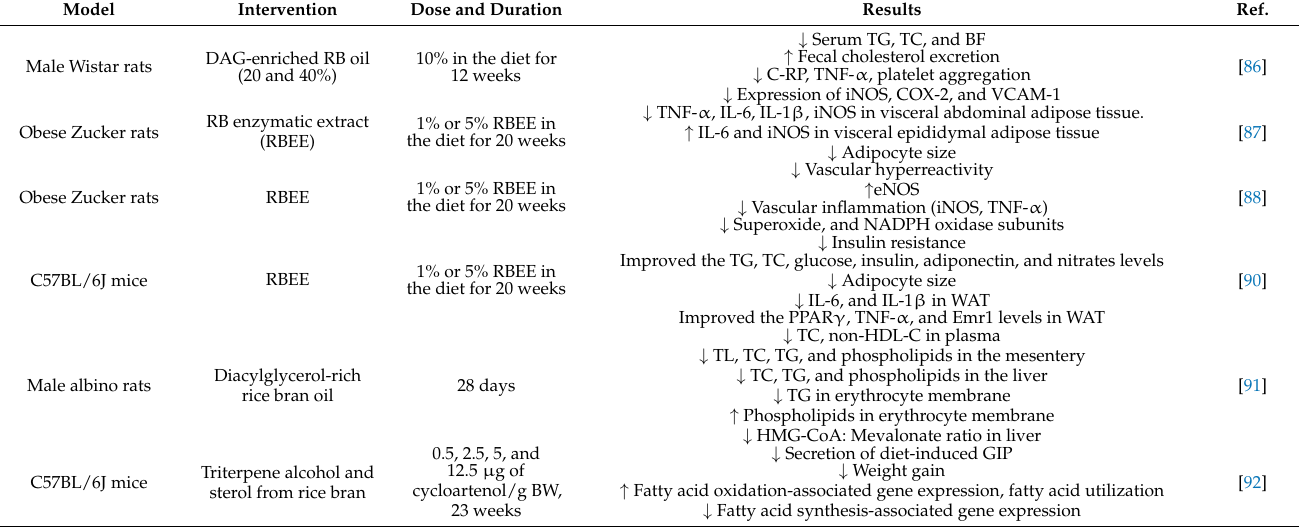
Table 2. Effects of rice bran supplementation on obesity-associated biomarkers: Results of in vivo